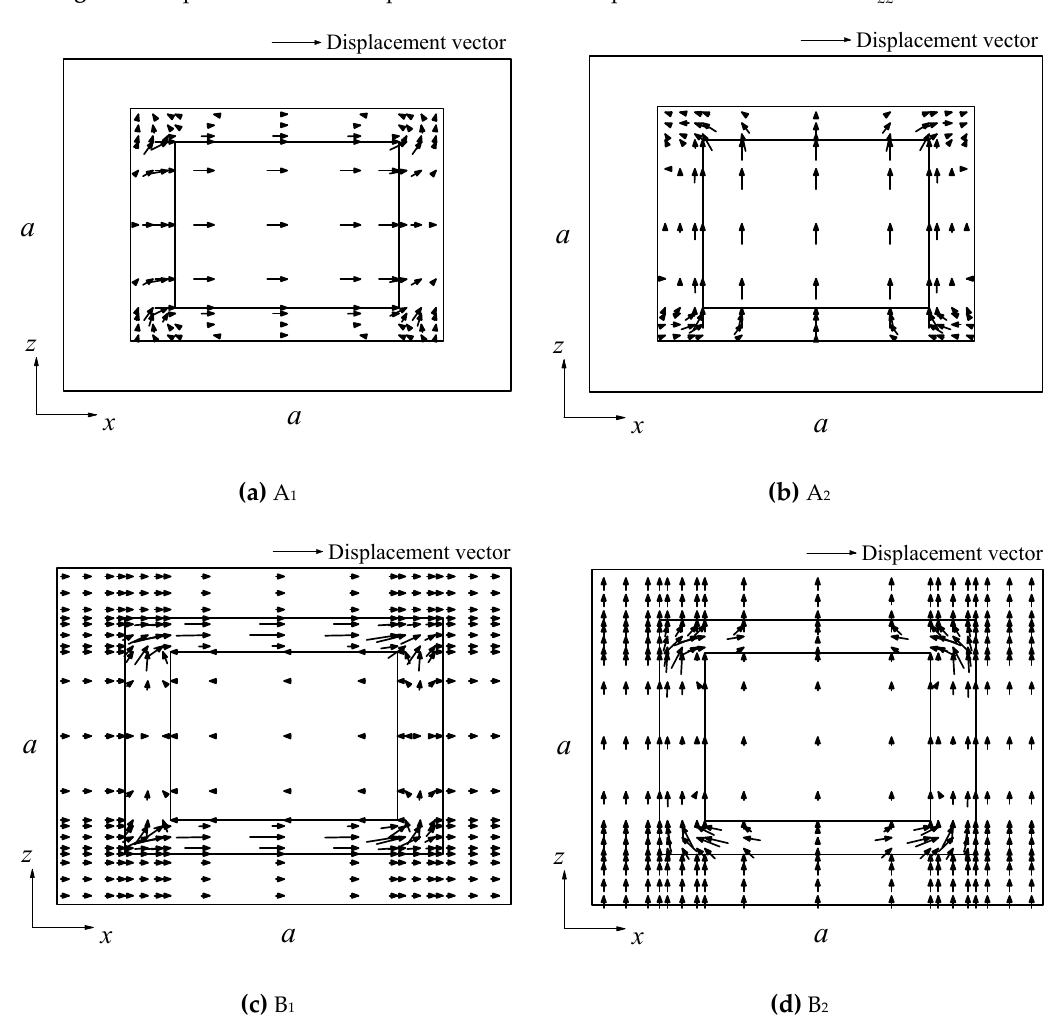
Figure 5. Mode shapes of the unit cell at the bound frequencies at ( a ) A 1 , ( b ) A 2 , ( c ) B 1 and ( d ) B 2 .